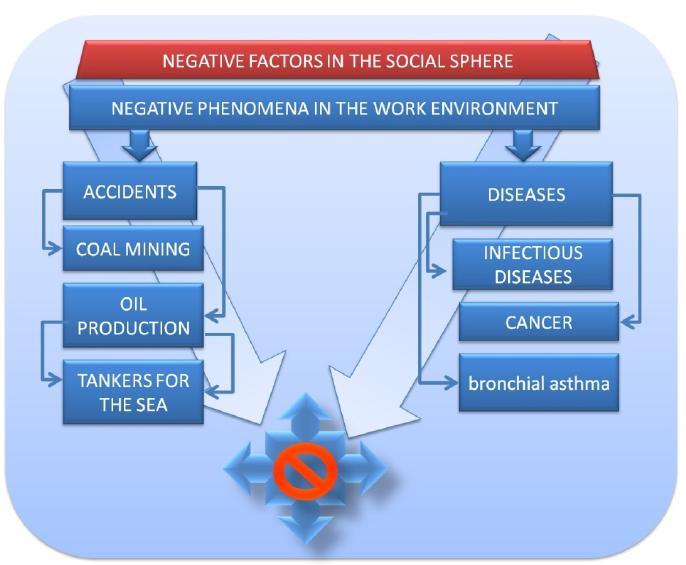
Figure 5. Negative factors in the social sphere [39,40].